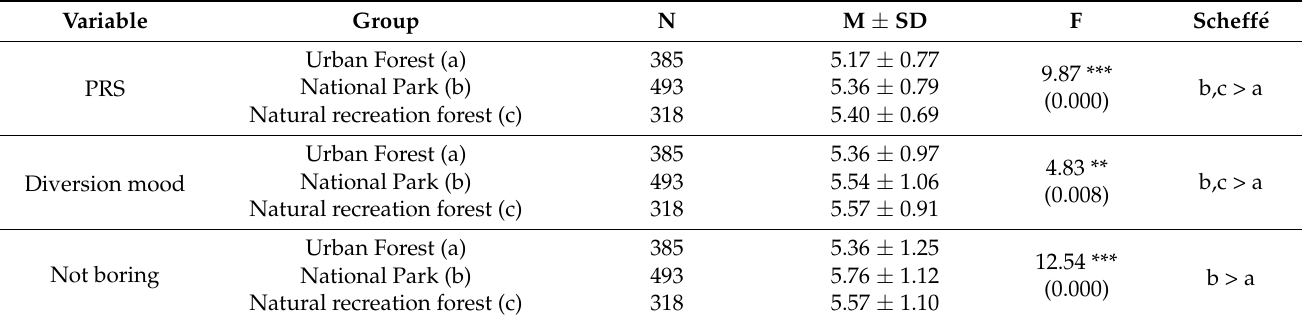
Table 6. Verification of major variable differences according to forest